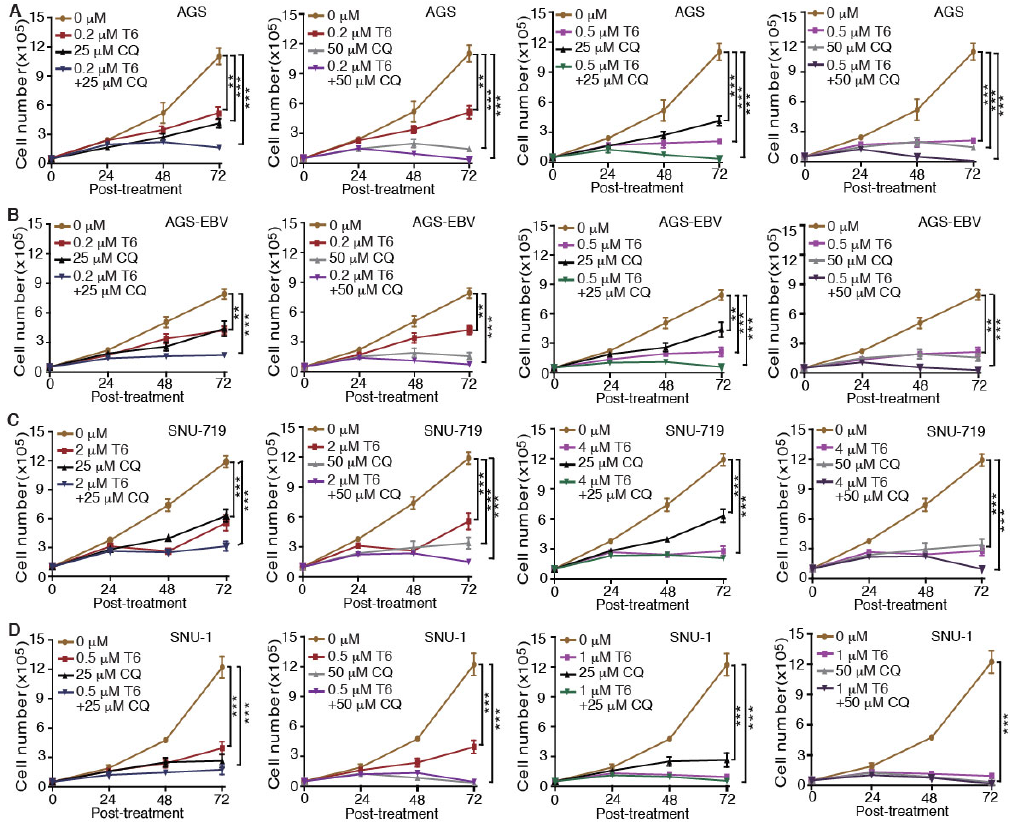
Figure 4. Chloroquine (CQ) enhances the inhibitory effect of Tenovin-6 (T6) on cell proliferation in GC cells. ( A – D ) Examination of cell proliferation in AGS ( A ), AGS-EBV ( B ), SNU-719 ( C ), and SNU-1 ( D ) cells following treatment with different concentrations of T6 or CQ alone, or in combination. * p < 0.05, ** p < 0.01, *** p < 0.001.